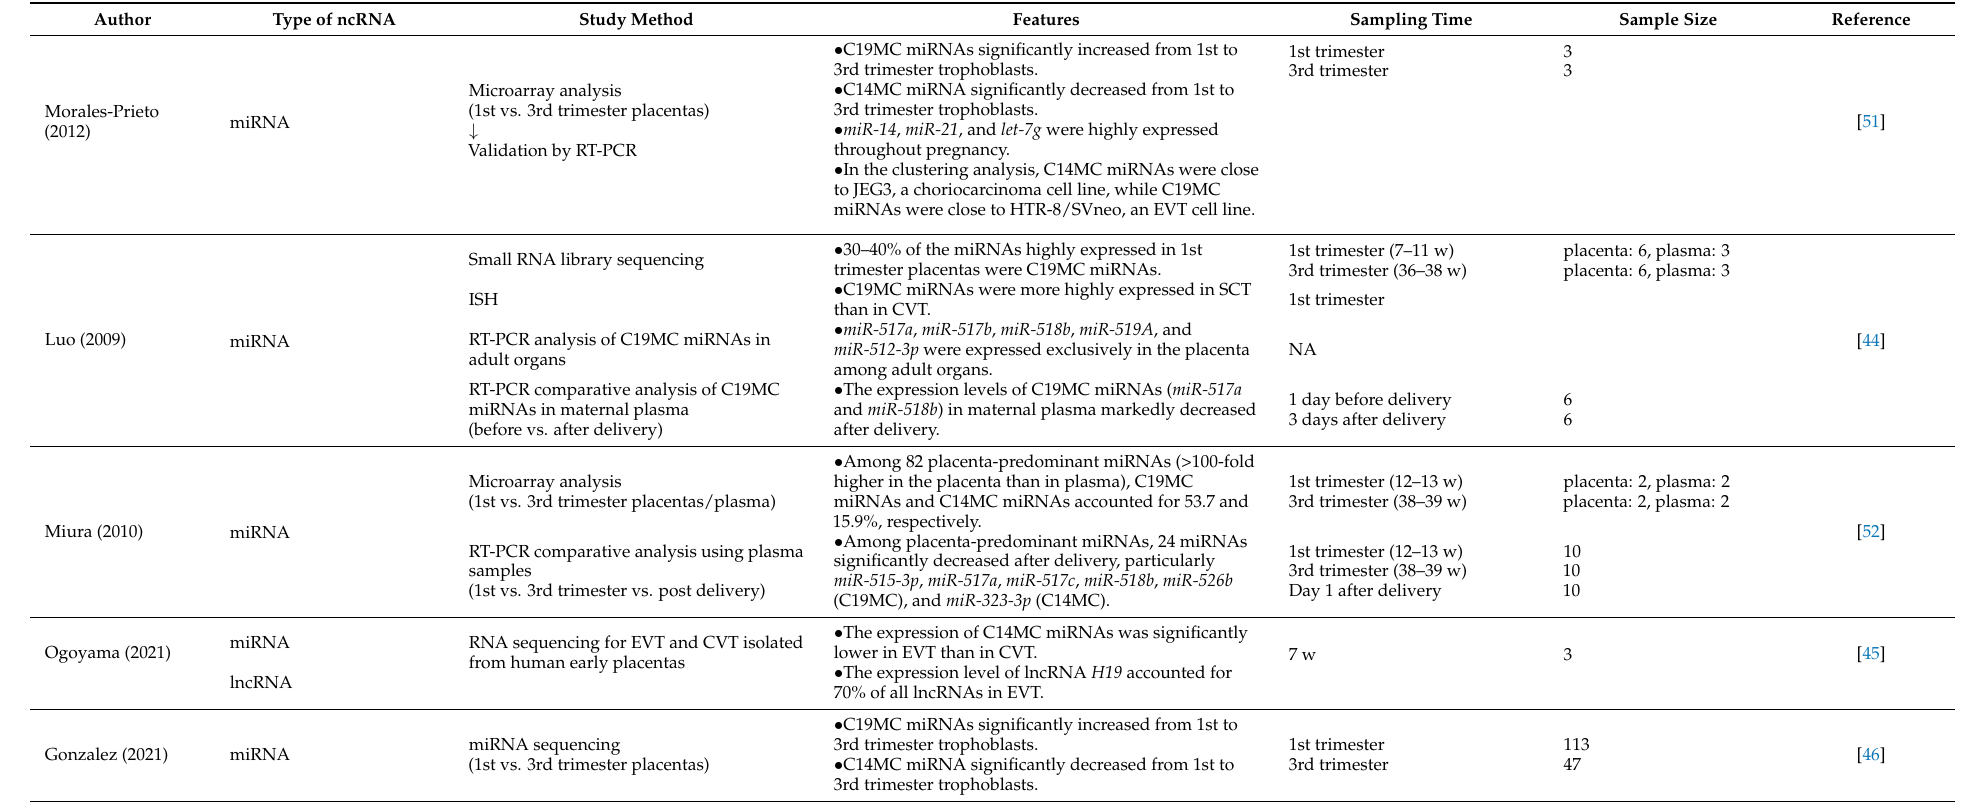
Table 1. Highly expressed non-coding RNAs in the human early placenta (Profiles of non-coding RNAs in 1st trimester